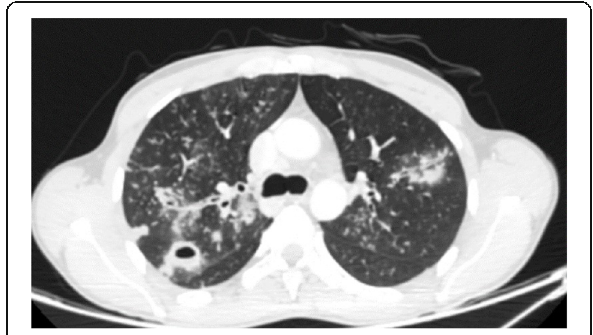
Fig. 21 Post primary pattern of tuberculosis: thin section CT shows bilateral tree-in-bud opacities and a cavitary masslike consolidation in the right upper